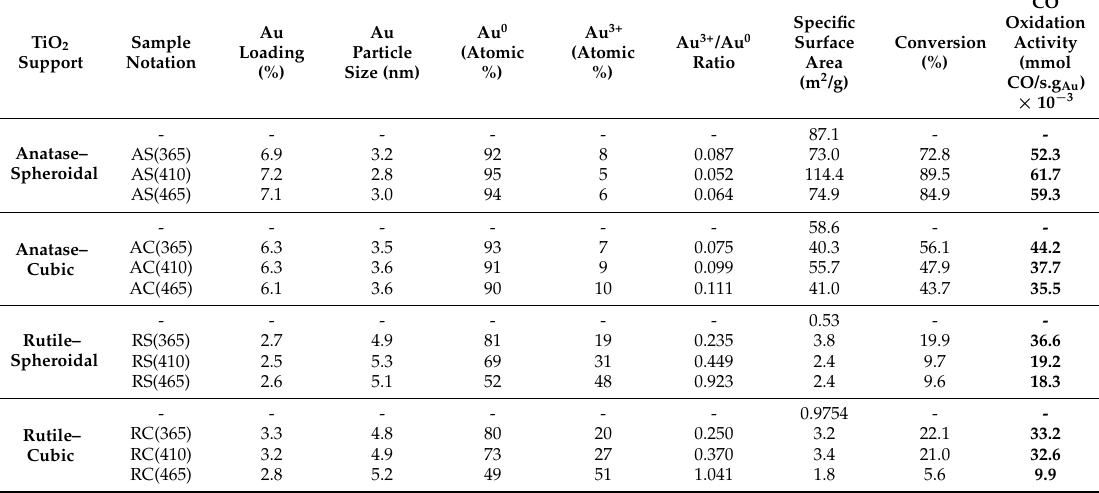
Table 1 compiles the results of X-ray photoelectron spectroscopy (XPS), Brunauer, Emmett and Teller (BET), CO oxidation activity and CO conversion results of different catalysts. Among all, anatase spheroidal TiO 2 support having highest specific surface area (87.1 m 2 /g) enabled highest gold loading (7.2%) and catalyst specific surface area (114.4 m 2 /g) which then enabled comparatively highest CO oxidation activity (61.7 × 10 − 3 mmol CO/s.g Au ). As shown in Figure 6, the as-prepared Au-TiO